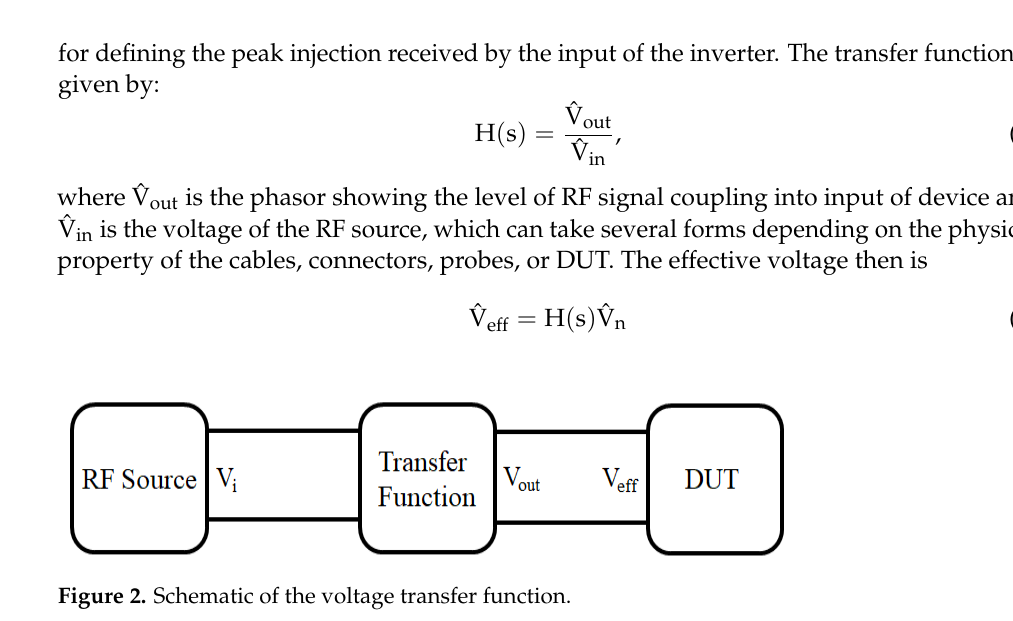
Figure 3. Cross-section of the pad capacitance and substrate resistance.